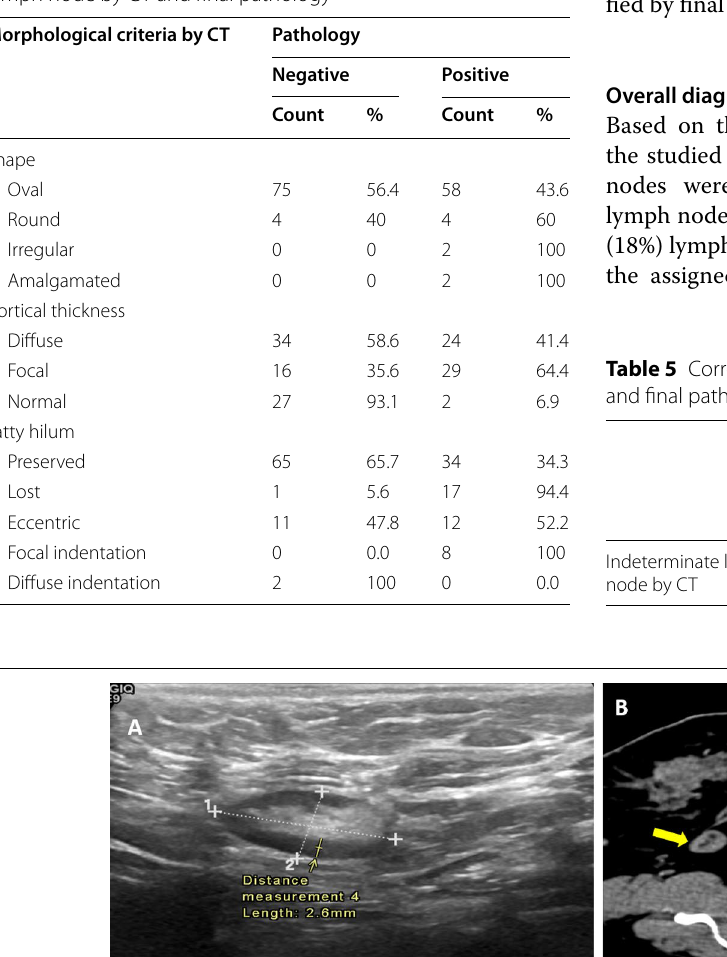
Table 4 Correlation between the morphological criteria of the